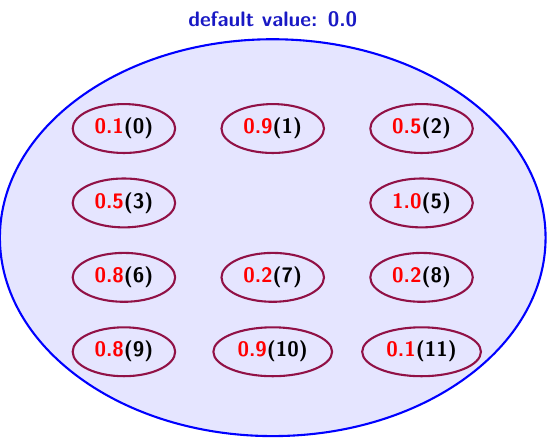
Figure 6. φ ( X 1 , X 2 , X 3 ) as the relation between values and